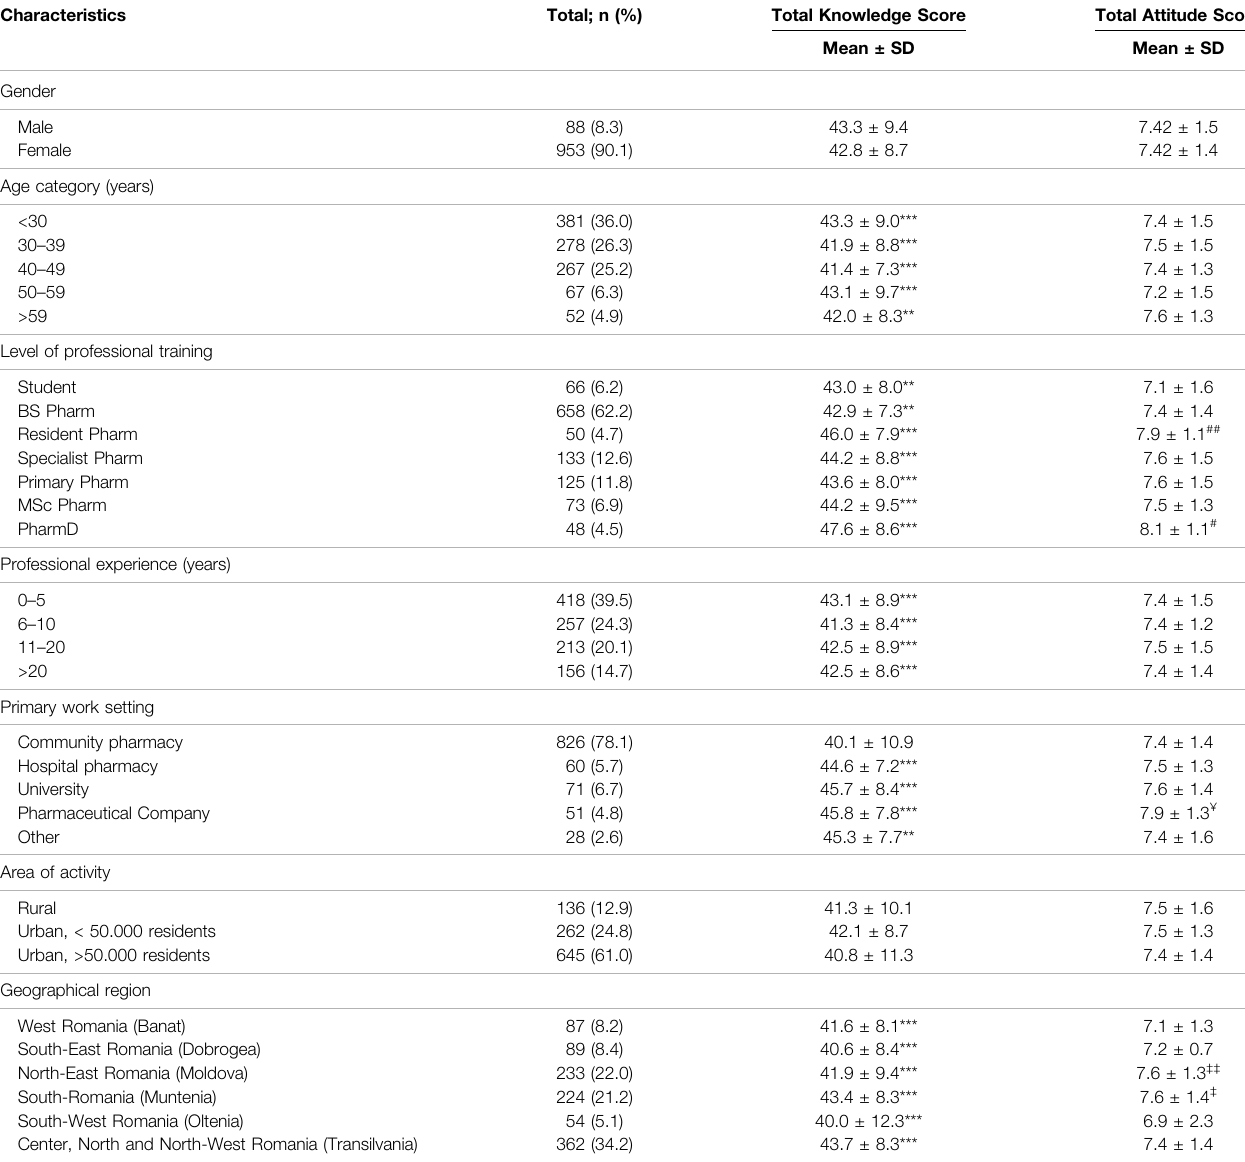
TABLE 3 | Knowledge and attitude scores association with respondents characteristics ( n = 1,058) † . Characteristics